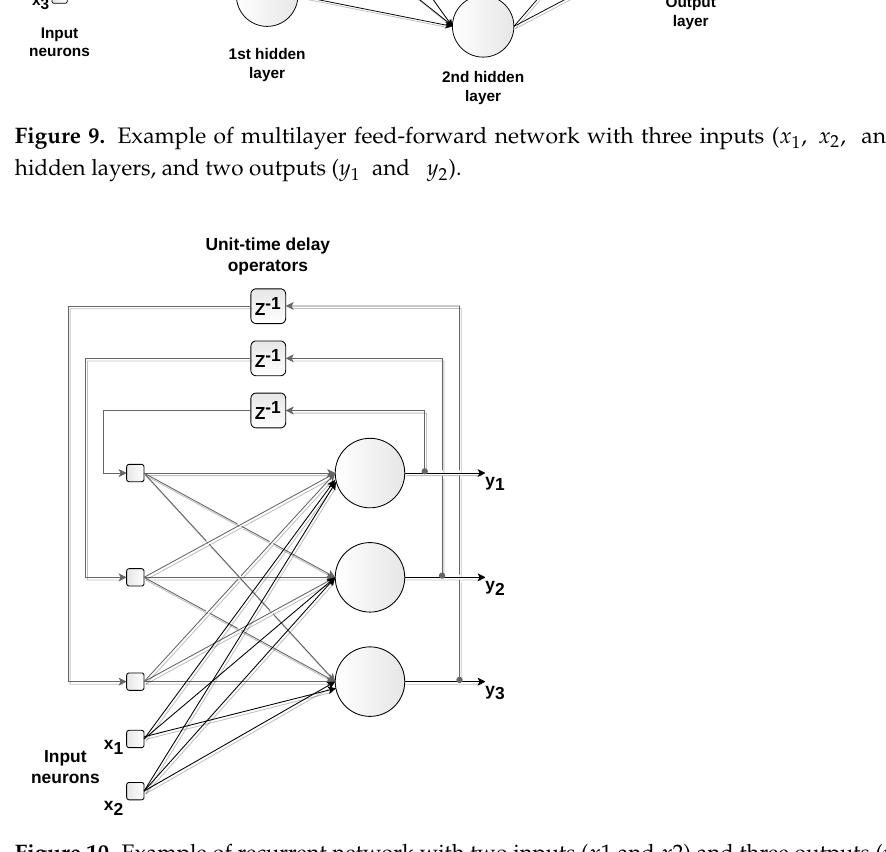
Figure 10. Example of recurrent network with two inputs ( x 1 and x 2) and three outputs ( y 1, y 2, and y 3). The time-delayed outputs are used as inputs for feedback on the